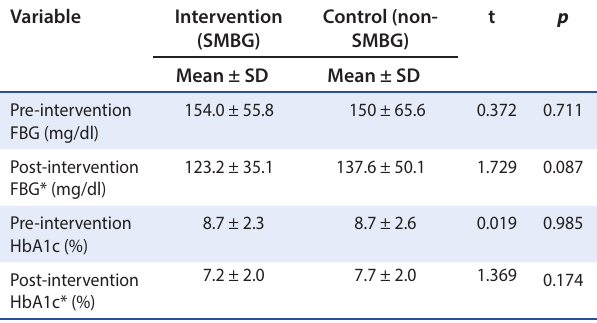
Note: N = 120. *= 107 (52 control and 55 in intervention group who completed the study).